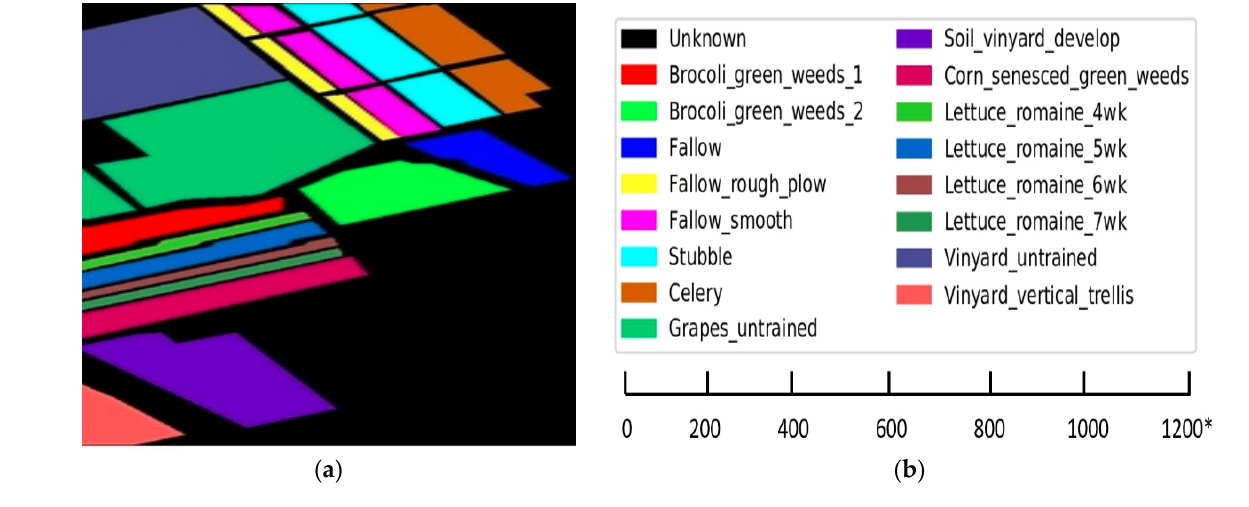
2 Salinas (SA): the Salinas dataset has 224 bands and was collected by the AVIRIS sensor. The Salinas dataset is from the Salinas Valley, California, and has a spatial resolution of 3.7 m. In the SA dataset, 20 bands are removed as they are disturbed by water absorption. It includes vegetables, bare soil, and vineyard fields. Figure 7a shows Salinas map and Figure 7b gives the scale bar of Salinas dataset. Table 3 show the Salinas image with 16 classes.